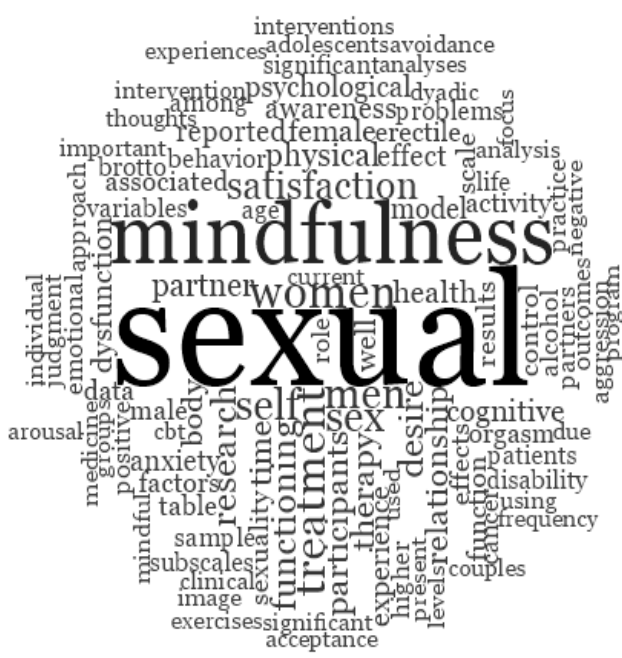
Figure 2. Word cloud of the selected articles in English .